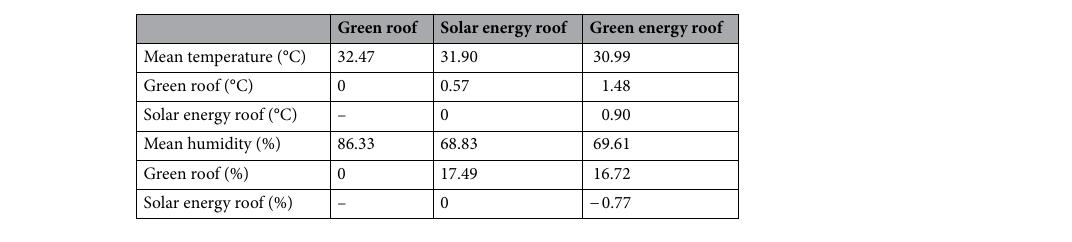
Table 10. Mean indoor temperature and humidity.